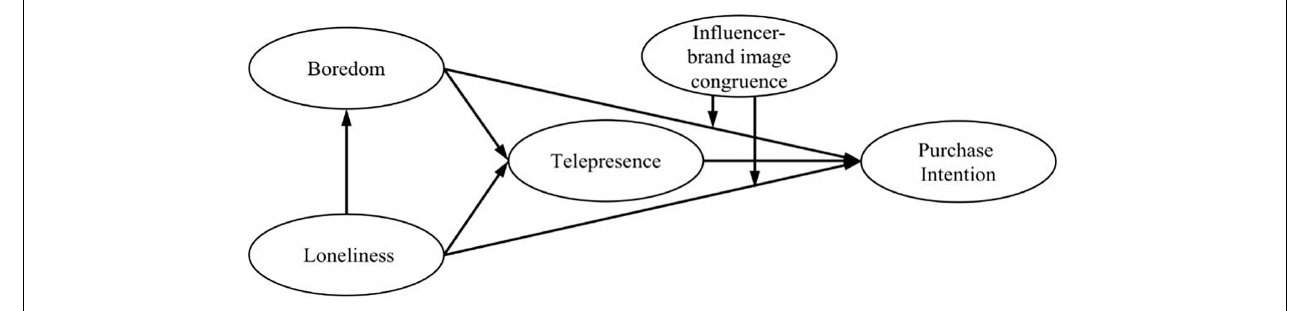
FIGURE 1 | Research